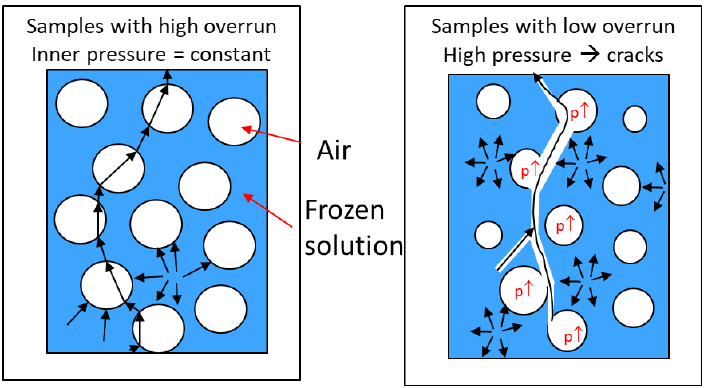
Figure 9. Schematic pathway of water during the drying of samples with high and low overrun values.